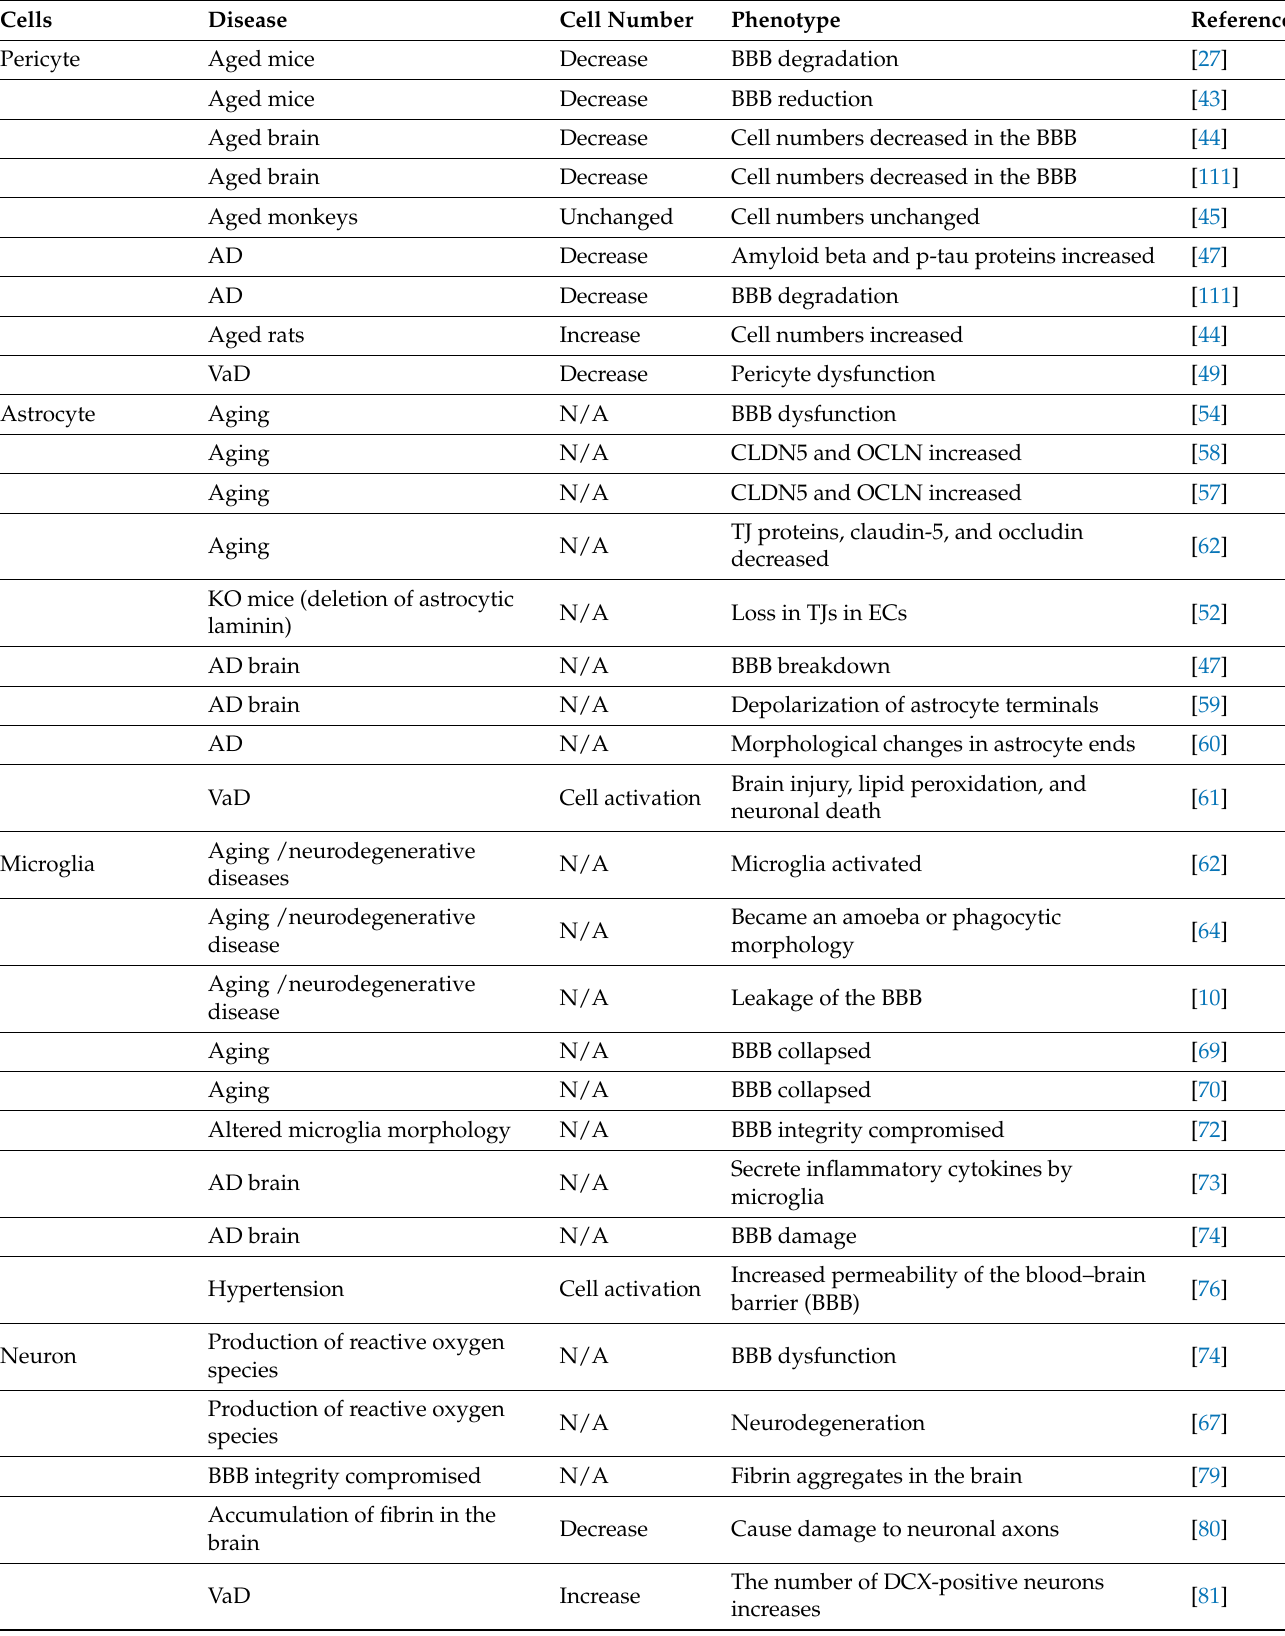
Table 1. Cells of the BBB in aging, Alzheimer’s disease (AD), and vascular dementia (VaD). (BBB: blood–brain barrier, AD: Alzheimer’s disease, VaD: vascular dementia, and N/A: not